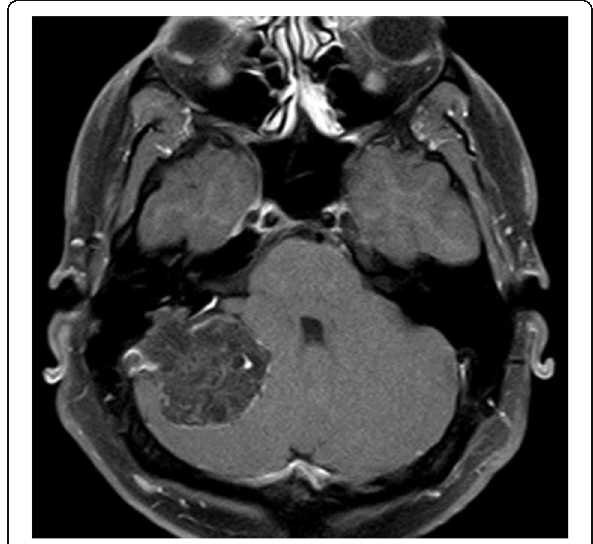
Fig. 11 Endolymphatic sac tumor. Axial post-contrast T1-weighted MRI shows a bulky mass with mild heterogeneous enhancement that projects into the right posterior fossa from the posterior aspect of the right petrous